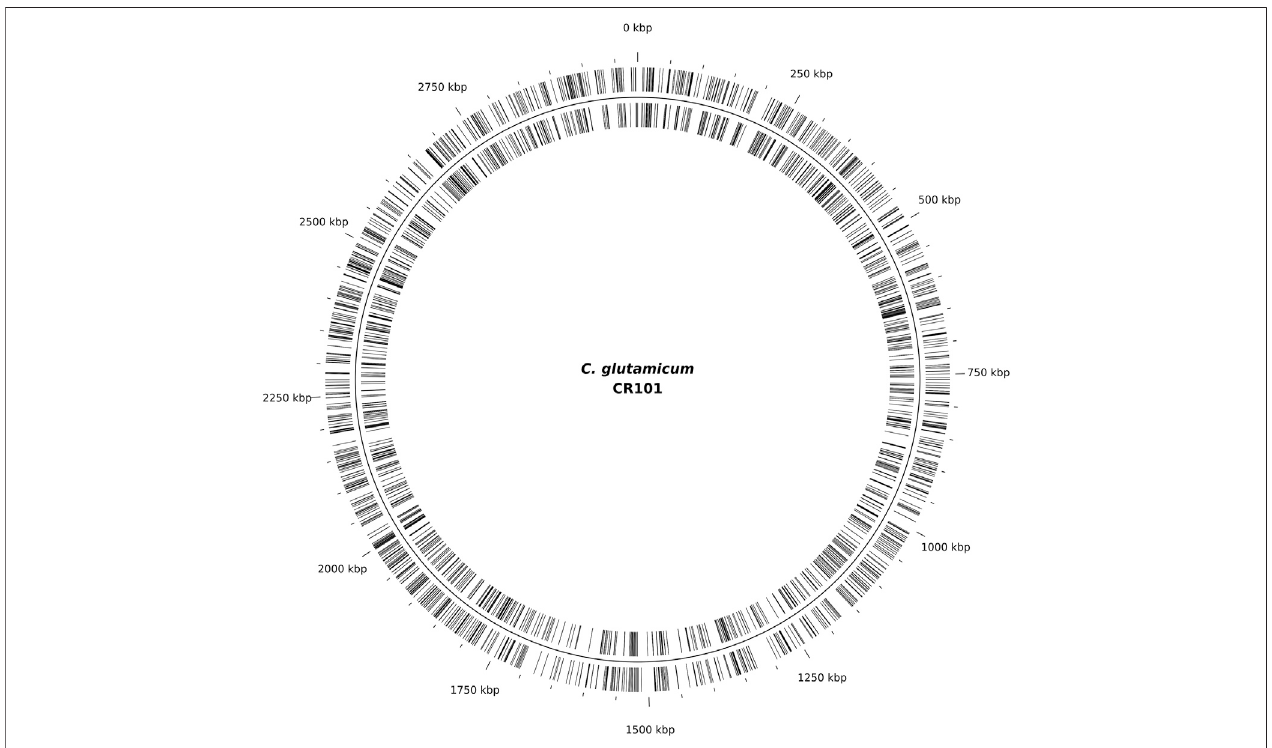
FIGURE 3 | Transposition sites mapped to the genome of CR101. A total of 3,207 transposition sites were identi fi ed by mapping sequencing reads of the random mutagenesis experiment performed with C. glutamicum ML103 to C. glutamicum CR101, with 1,582 sites on the leading strand (outer lines) and 1,625 sites on the lagging strand (inner lines).